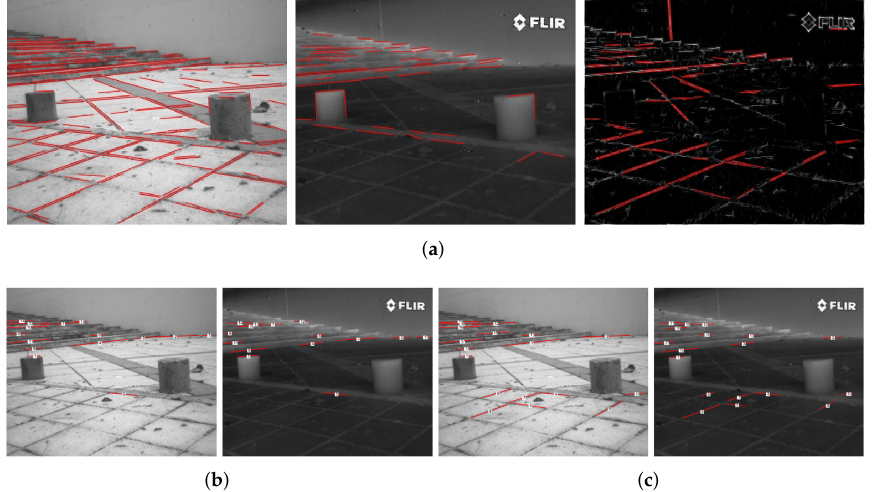
Figure 3. Illustration of line segment fusion results. ( a ) Line segment detected in VS, IR image, and PC of IR image. ( b ) Matching result using VS and IR images. ( c ) Matching result after line segment fusion.